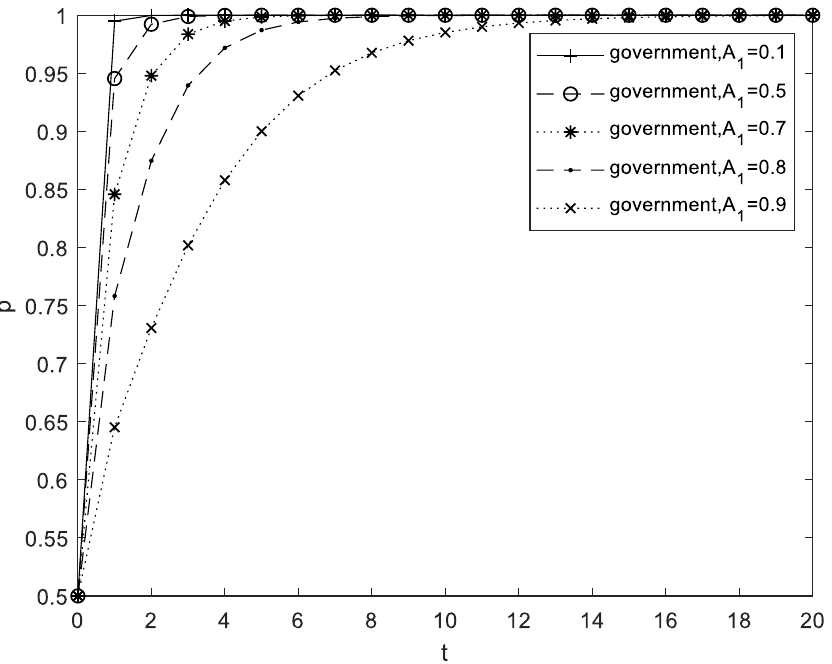
Figure 10. The influence of government regulatory agencies’ regulation on the results of the system evolution.